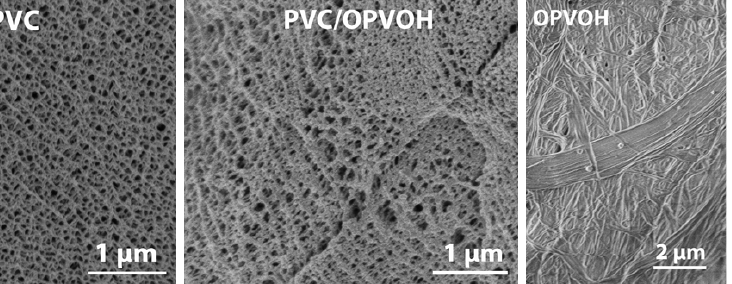
Figure 1. Photomontage from scanning electron microscopy images of PVC gels ( C PVC v = 0.4 × 10 −2 g/cm 3 ) ( left ), OPVOH gels ( C OPVOH = 0.5 × 10 −2 g/cm 3 ) ( right ) and the hybrid system with the same concentrations ( center ).